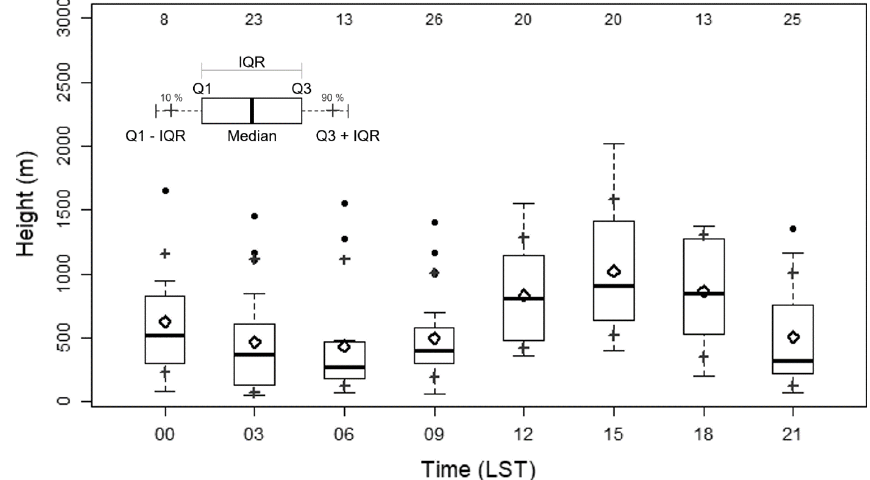
Figure 8. Box plot of 3h interval ABLHs estimated using the 148 radiosondes observed at Jungnang Station from 2015 to 2018. The rhombus is the mean ABLH, the dots are outliers, and the gray crosses represent the 10th and 90th percentiles, respectively. IQR implies an interquartile range. The numbers at the top indicate the data